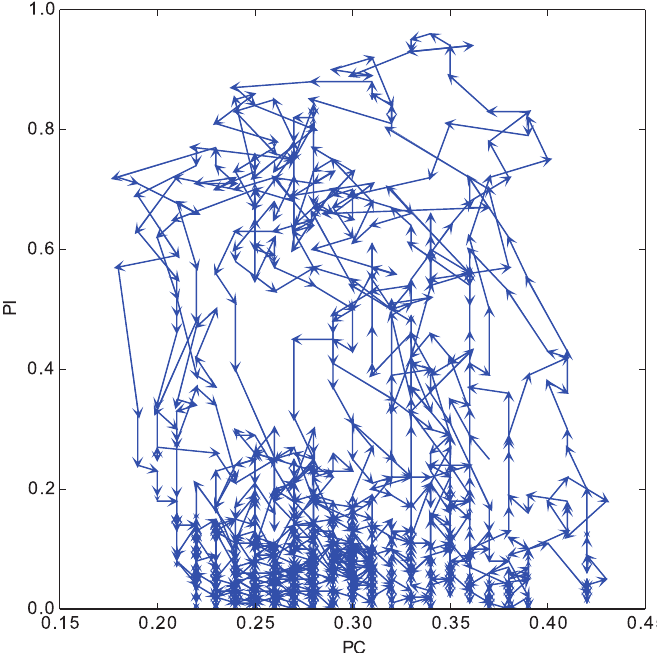
Figure 7. The trajectory of the proportion of cooperative behaviors ( PC ) and the proportion of individuals ( PI ) in the layer (0) of the top panel in Figure 6. The cyclic coevolution process of these indices occurred